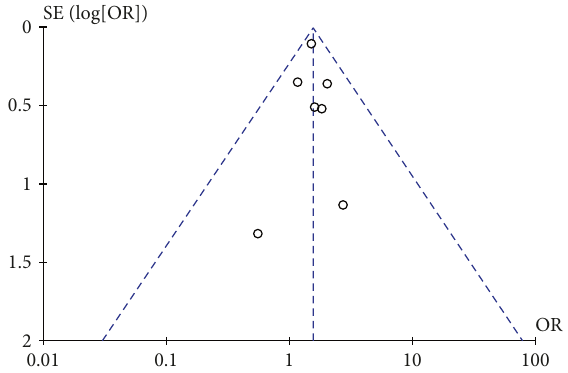
Figure 6: Funnel plot of publication bias in terms of HbA1c level and all-cause mortality in all diabetic patients.